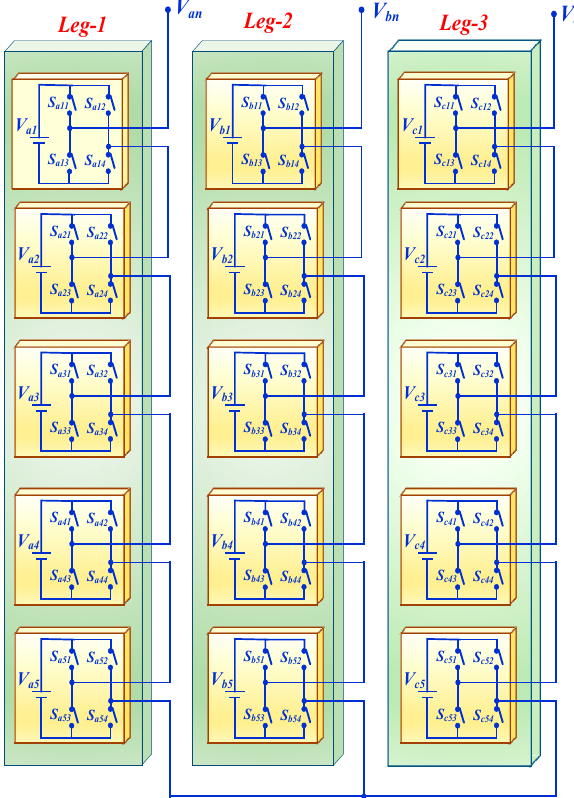
Figure 1. Eleven-level, three-phase cascaded H-bridge